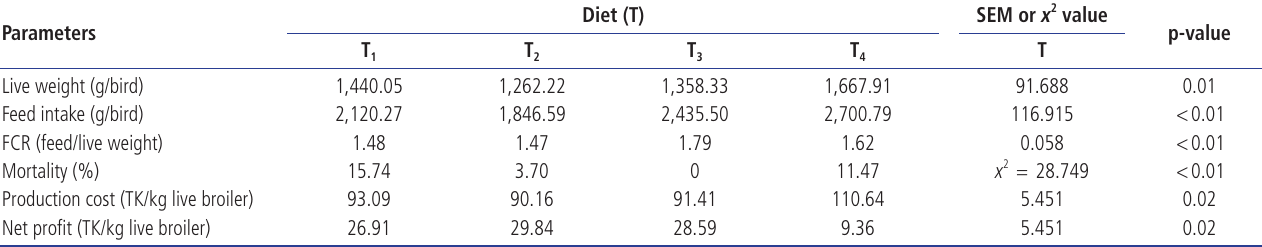
Table 4. Effect of Azolla or combination of multivitamin and acidifier on growth performance of broiler chickens at 35 days of age